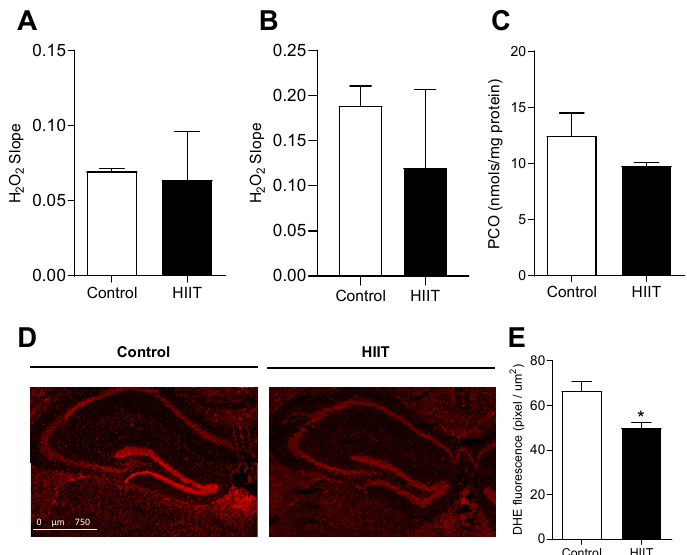
Figure 5. Effect of five-week HIIT on the redox state in the hippocampus and dentate gyrus. The same HIIT protocol training performed during the one-week analysis was repeated over five weeks. ( A ) hydrogen peroxide (H 2 O 2 ) production in the hippocampus and ( B ) cerebral cortex (control n = 3; HIIT n = 3); ( C ) carbonylated protein concentration in the hippocampus (control n = 3; HIIT n = 2); ( D ) dihidroetideo (DHE) fluorescence—superoxide anion; ( E ) superoxide anion production in dentate gyrus (control n = 4; HIIT n = 4); Slope: variation rate of UF/t normalized by protein content (UF: unit of fluorescence). Statistical analyses were performed by the Student’s t -test using * p < 0.05.